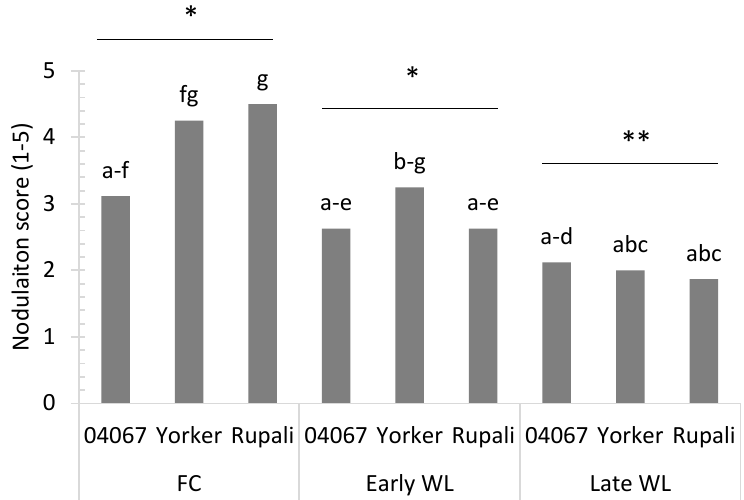
Figure 5. Main waterlogging (WL) and two-way genotype by WL effects on nodulation (1 poor – 5 extensive) in three chickpea genotypes following WL treatments (field capacity (FC), early WL and late WL). Letters indicate the significant difference in the two-way interaction ( p < 0.001). * and ** indicate significant differences at the main effect level WL ( p < 0.001).